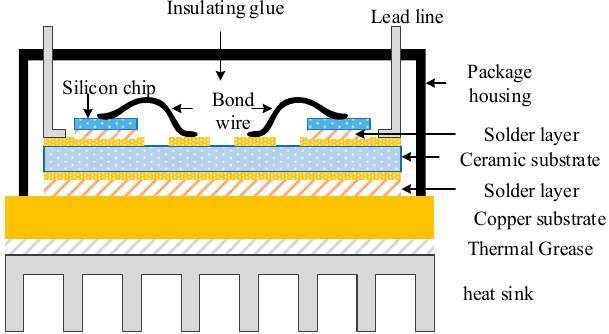
Figure 1. Diagram of insulated gate bipolar transistor (IGBT) cross-sectional structure.